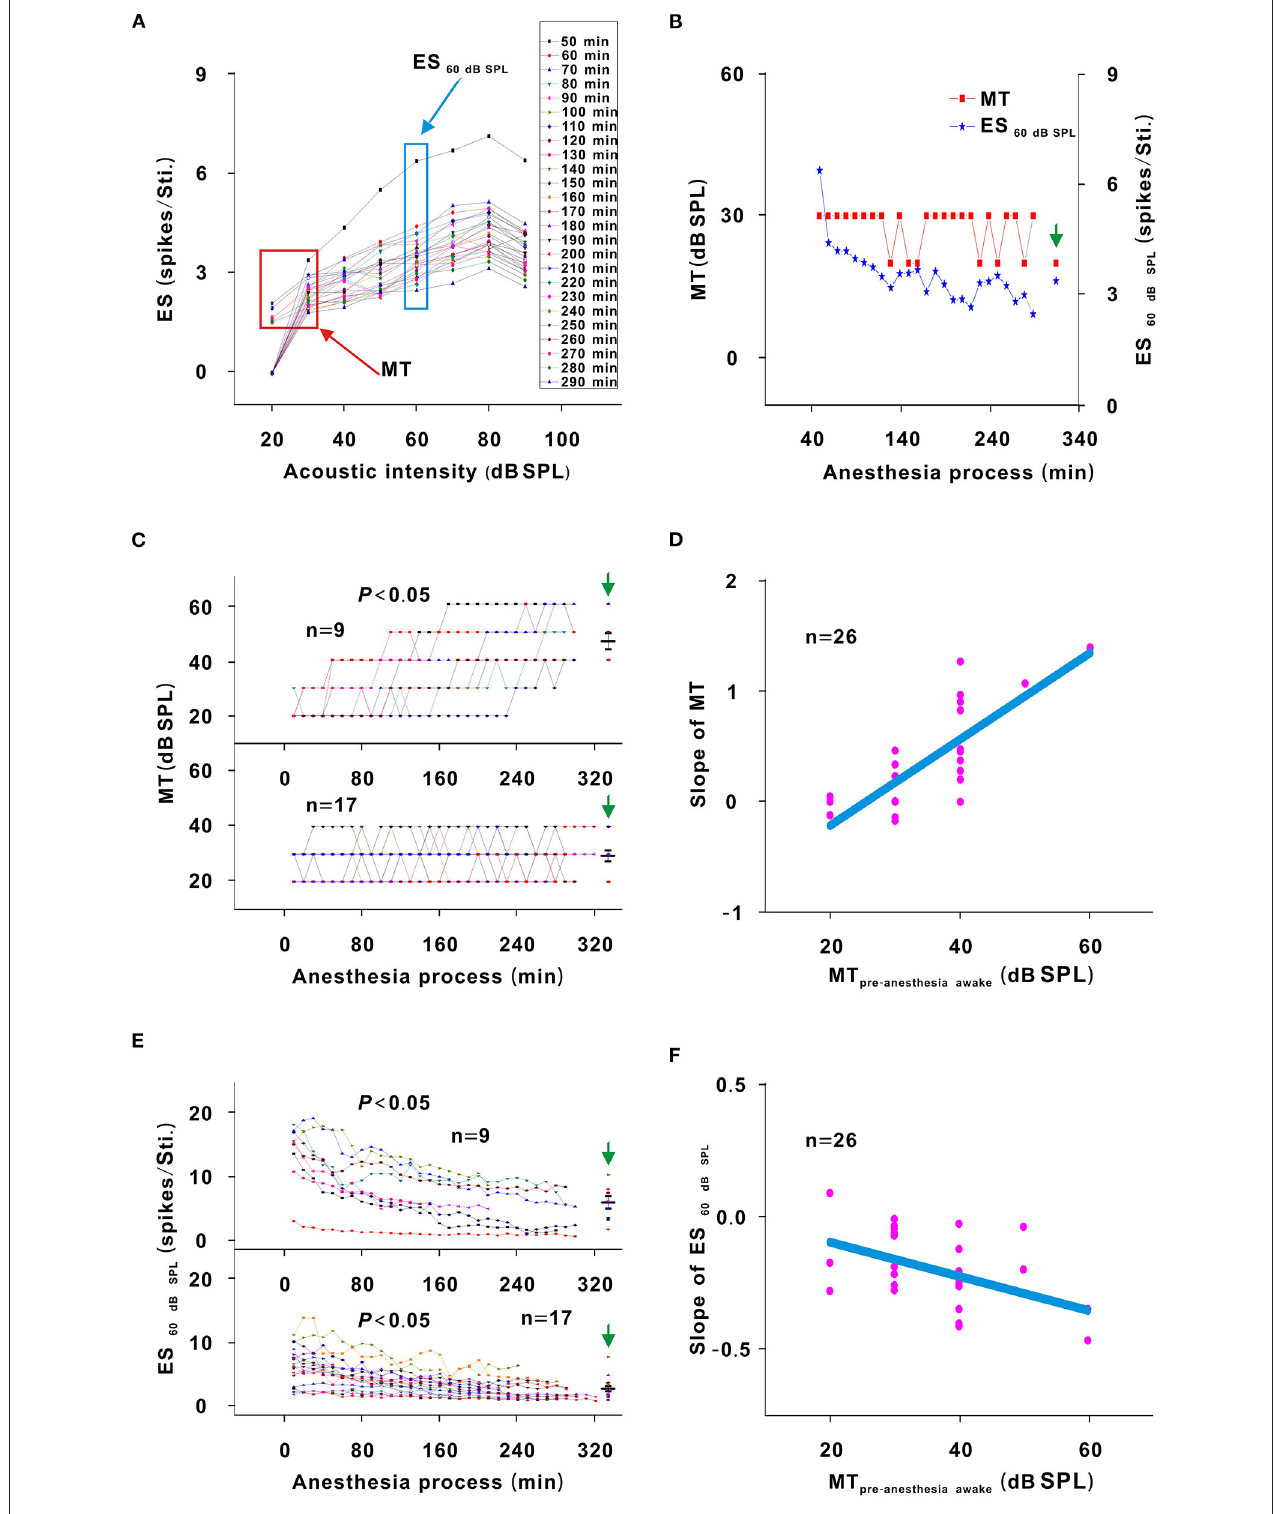
FIGURE 3 | Changes in the response intensity of neurons. (A) ES changes with acoustic intensity. The red and blue frames indicated the MT and ES 60 dB SPL of all recording sessions, respectively. (B) MT and ES 60 dB SPL changes with anesthesia time (red curve and left ordinate for the MT; blue curve and right ordinate for the ES 60 dB SPL ), hereafter, the MT- and ES 60 dB SPL -time curves. The vertical green arrow labeled the data recorded under the pre-anesthesia awake state (the same